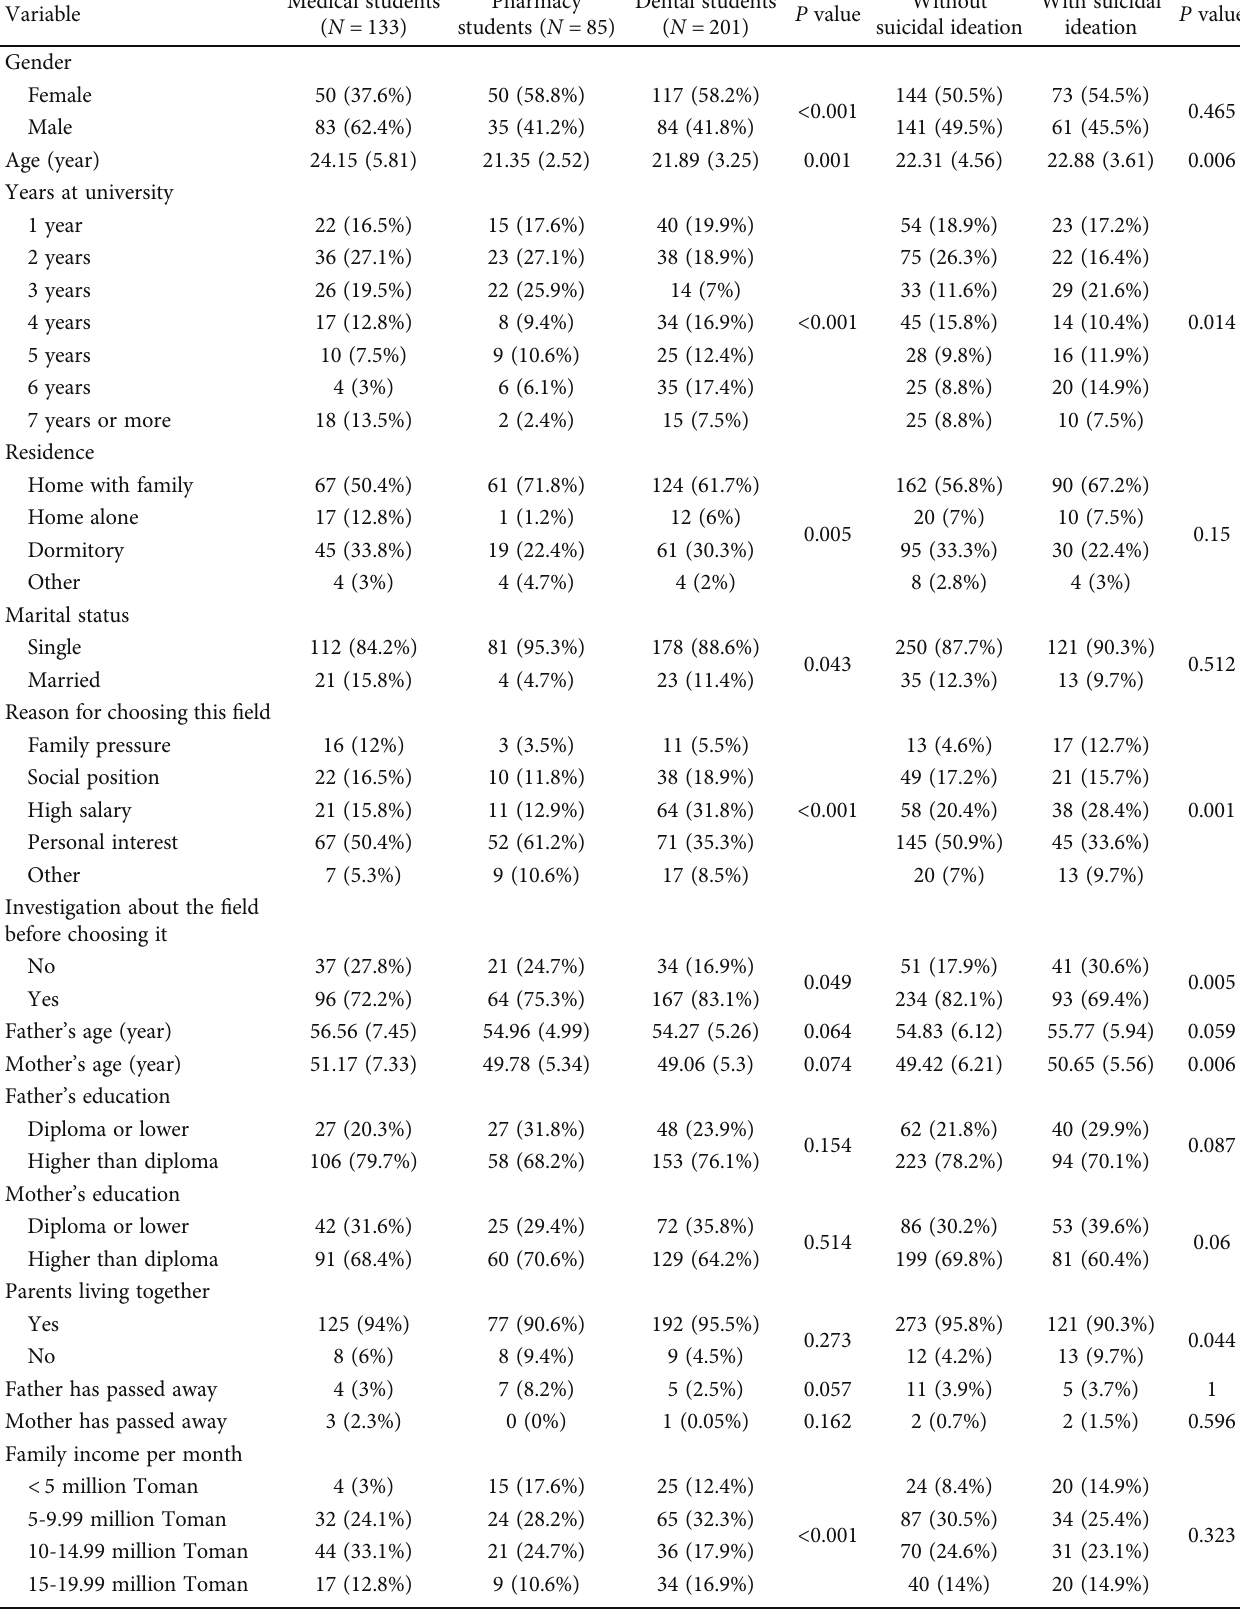
Table 1: Family history and basic and demographic characteristics of